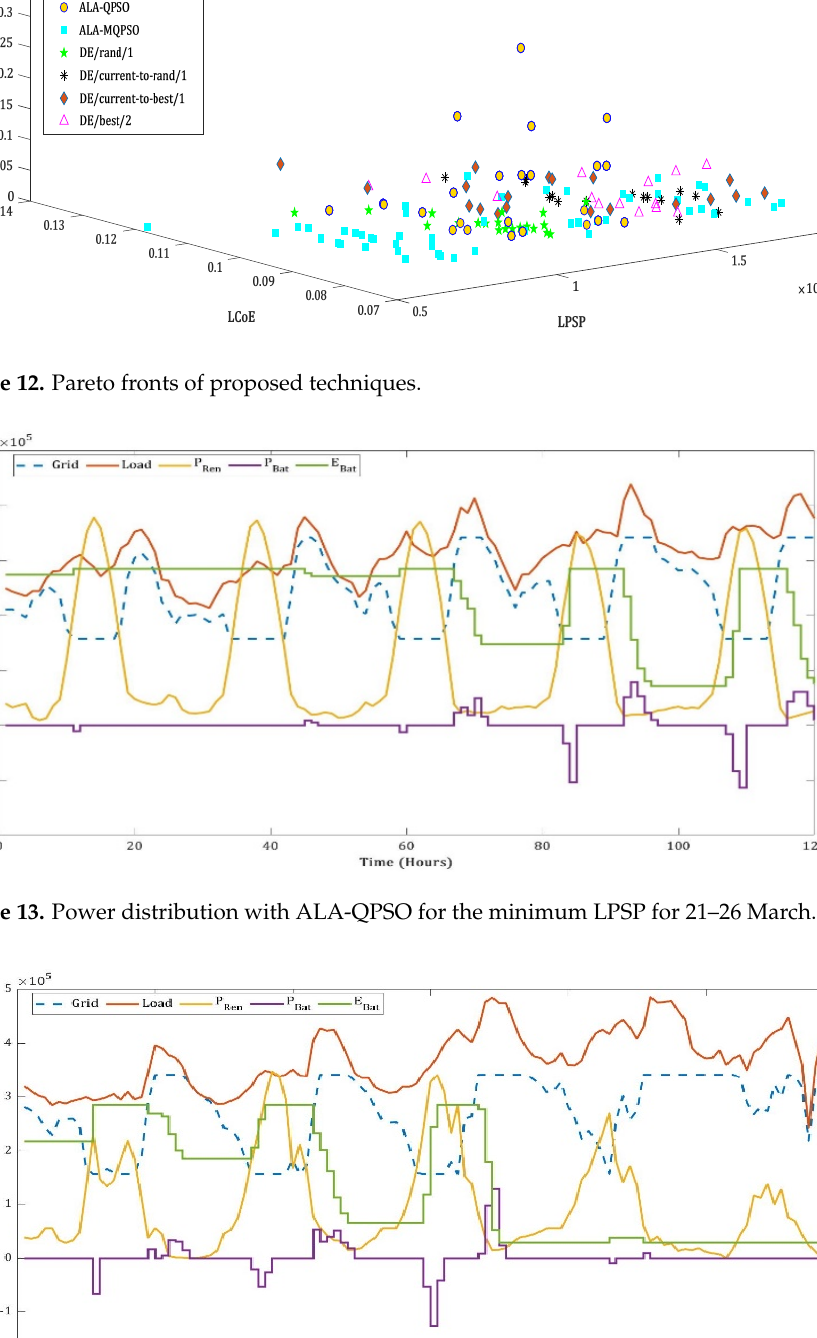
Figure 15. Power distribution with ALA-QPSO for the minimum LPSP for 21–26 September. Figure 16. Power distribution with ALA-QPSO for the minimum LPSP for 21–26 December.